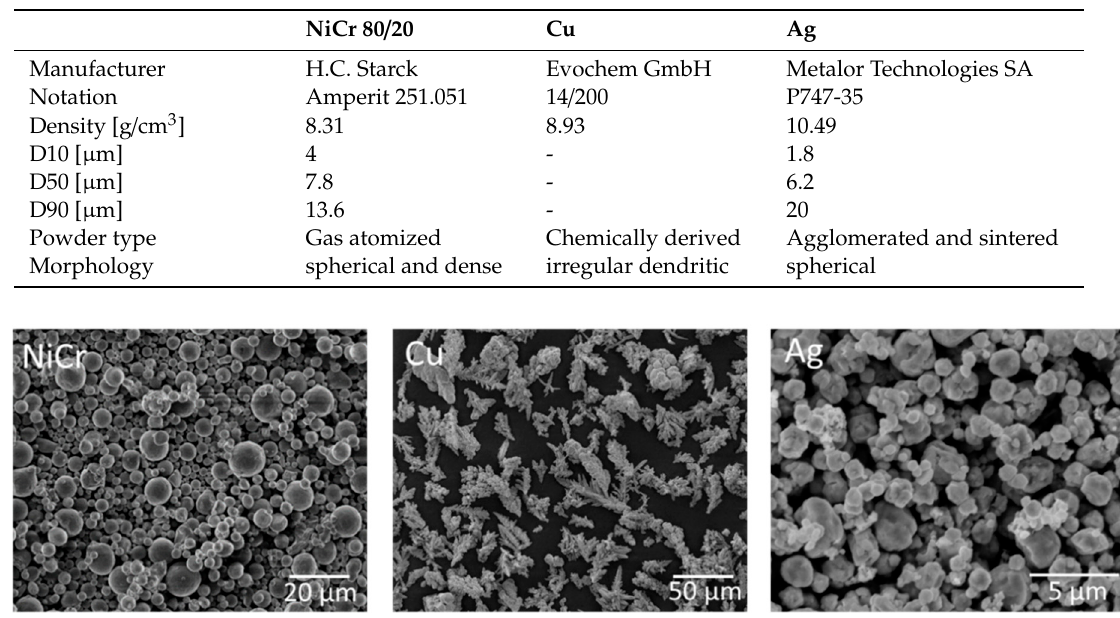
Table 1. Overview of the commercial powders used for suspension preparation. All data in this table are according to supplier datasheets.